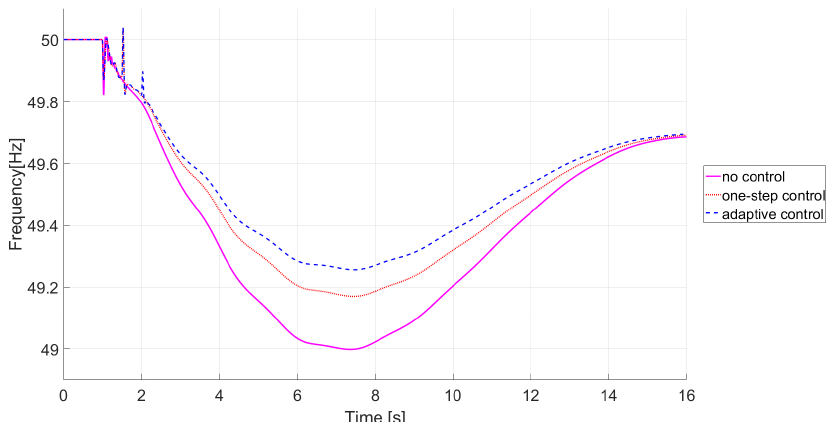
Figure 18. Frequency at bus 39 in Configuration II in case of small